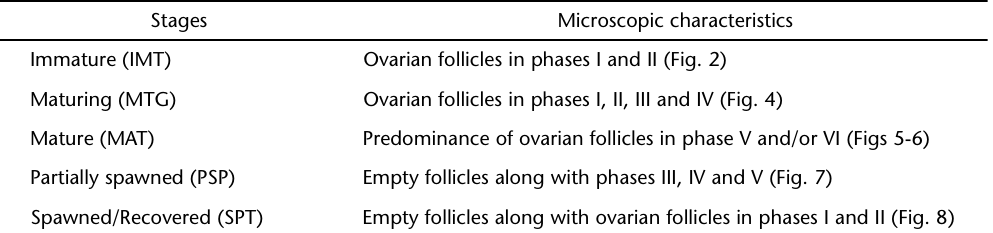
Table II. Description of the five stages of ovarian development observed in A. lineatus in the Paranaguá Bay, state of Paraná. The description is based on the frequency and composition of the phases of the ovarian follicle. Stages Microscopic characteristics